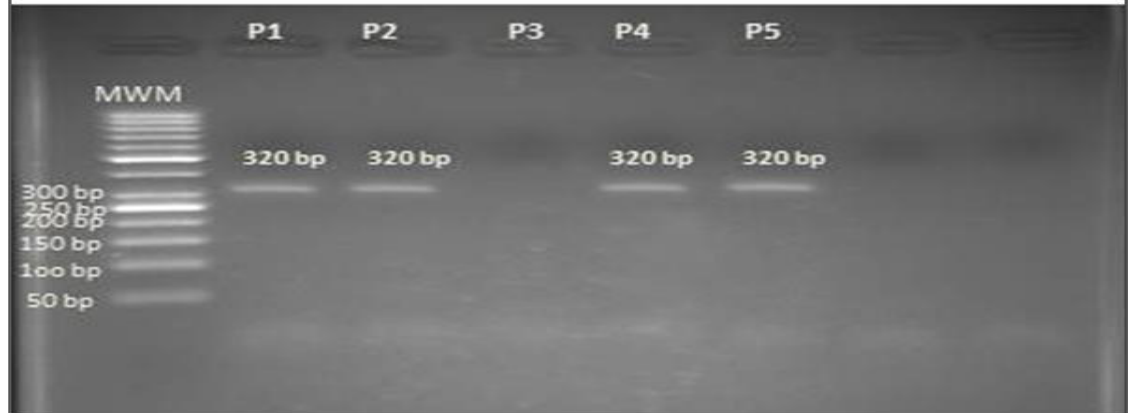
Figure 4 . Agarose gel electrophoresis of PCR products after amplification of mcr-1 gene. MWM-molecular weight marker (50 bp DNA ladder), P1, P2, P3, P4; P. aeruginosa positive for mcr-1 gene products (320